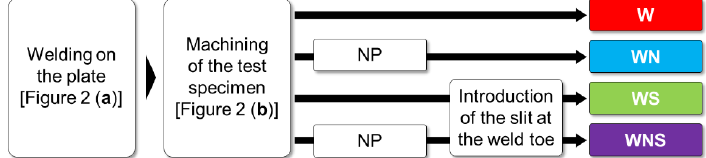
Figure 3. Flow chart of specimen preparation and types of specimens. Four groups of specimens were prepared, which were namely the welded specimen (W), NP-treated welded specimen (WN), welded specimen with a semicircular slit at the weld toe (WS) and NP-treated welded specimen with a semicircular slit at the weld toe (WNS).